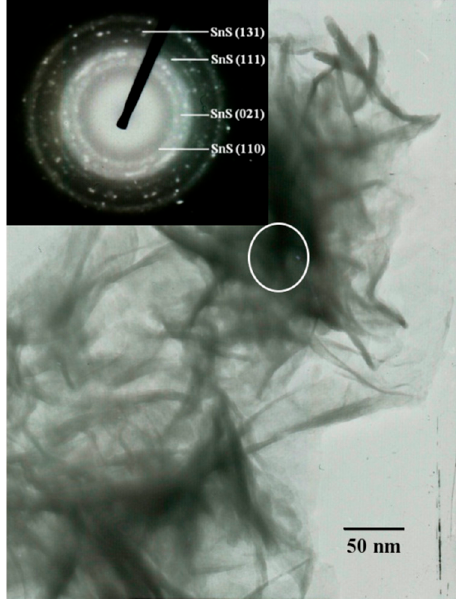
Figure 2. Transmission electron microscope (TEM) image and selected-area electron diffraction (SAED) pattern of the SnS structure of the as prepared 10SnS/AG sample. In all prepared nanocomposites, the SnS particles had this microstructure.